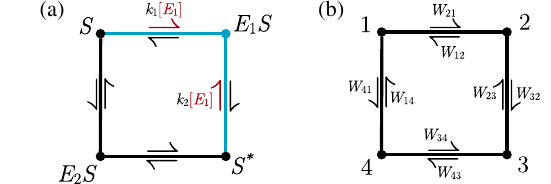
FIG. 14. (a) The transition graph G arising from the Goldbeter- Koshland model in the low-substrate limit, with product rebinding. Two transition rates (red) depend on the (assumed constant) free enzyme concentration ½ E 1 (cid:3) that we vary. Scaling ½ E 1 (cid:3) is equivalent to a perturbation of two edge parameters and one vertex parameter (blue). (b) State numbers and rate labels we use in this subsection. Key equivalences are 1 ¼ S , 3 ¼ S (cid:4) ,